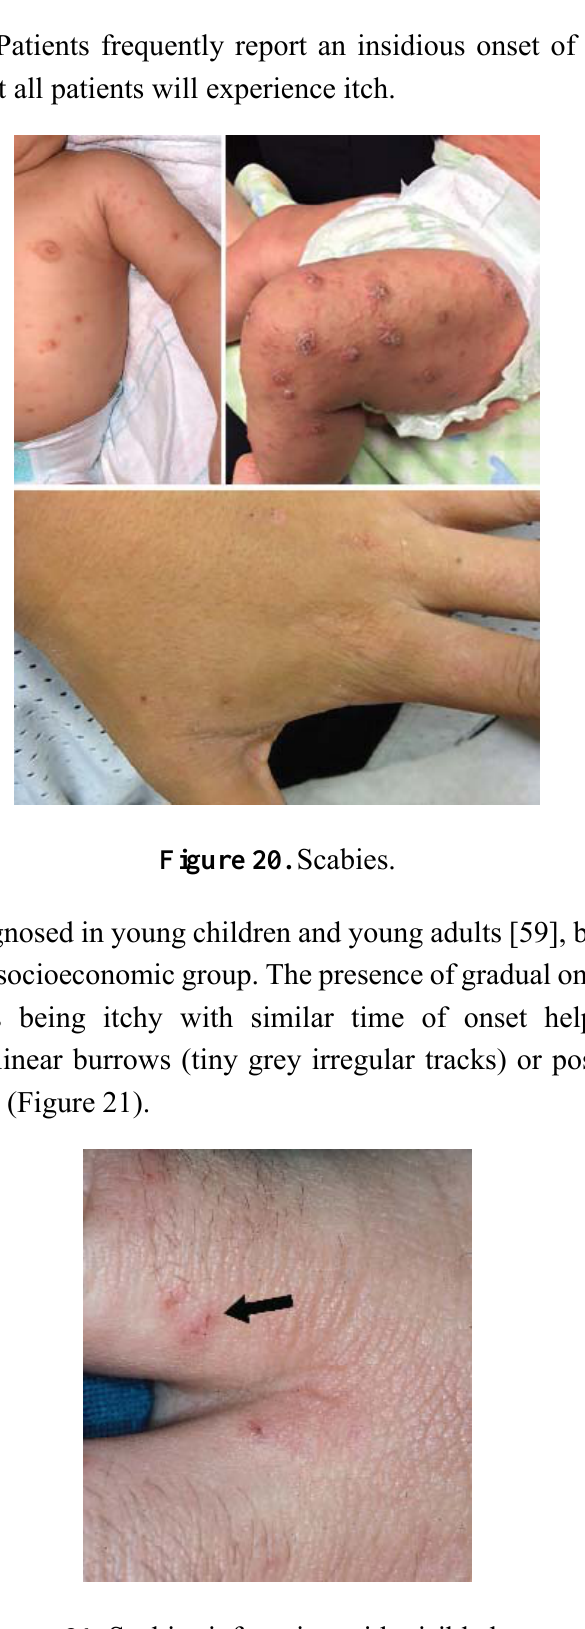
Figure 21. Scabies infestation with visible